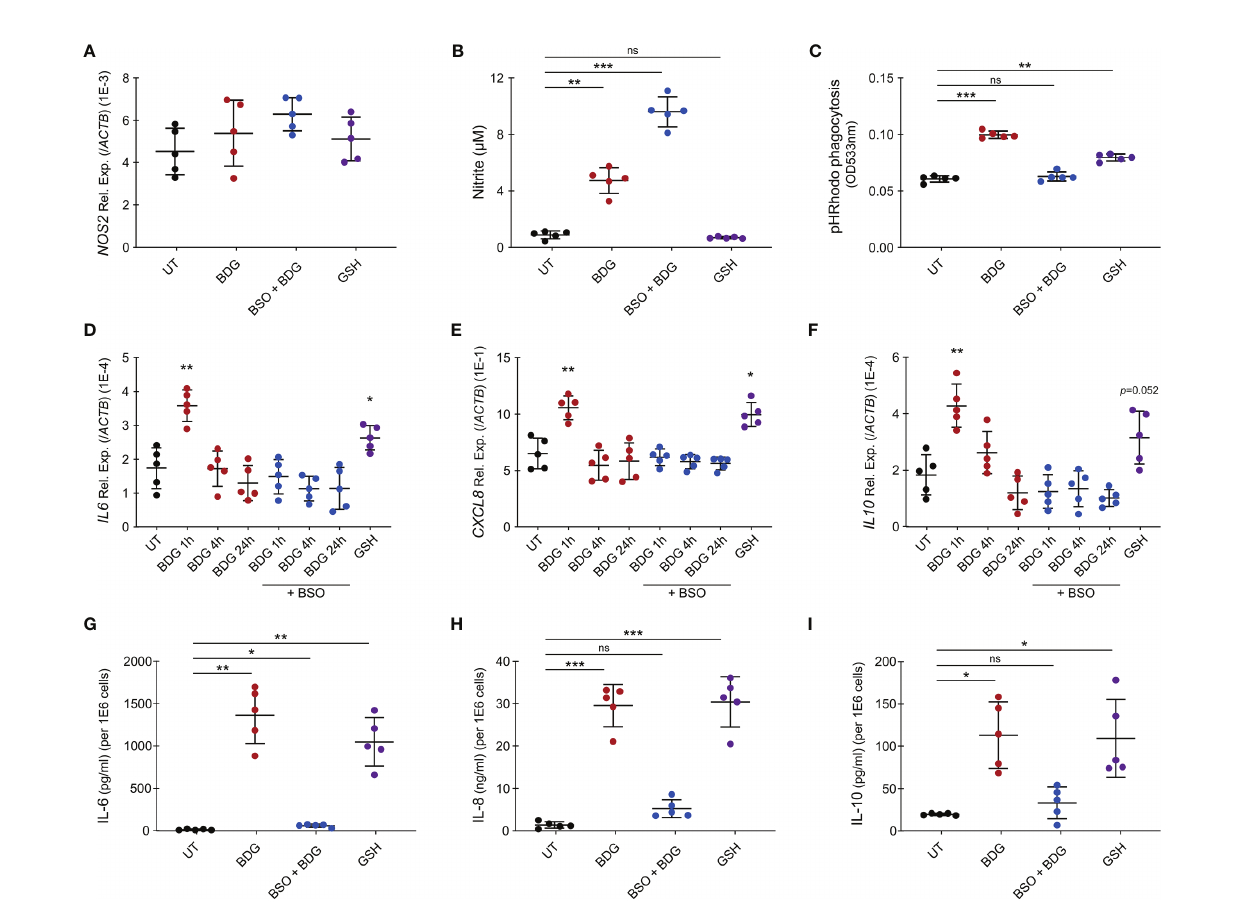
FIGURE 7 | Intracellular glutathione levels modulate monocyte ’ s in fl ammatory response to BDG stimulation. (A – C) Human monocytes were untreated, stimulated with BDG for 24h, pre-treated with BSO for 24h then stimulated with BDG for 24h, or stimulated with reduced glutathione (GSH) for 24h and assessed for (A) NOS2 expression, (B) Nitrite production, and (C) phagocytic capacity. (D – F) Human monocytes were untreated, stimulated with BDG for 1h, 4h, or 24h, pre-treated with BSO for 24h then stimulated with BDG for 1h, 4h, or 24h, or stimulated with GSH for 24h and then evaluated for expression of the (D) IL-6 , (E) CXCL8 , and (F) IL- 10 loci using RT-qPCR. (G – I) Human monocytes were untreated, stimulated with BDG for 24h, pre-treated with BSO for 24h then stimulated with BDG for 24h, or stimulated with reduced glutathione (GSH) for 24h and assessed for production of (G) IL-6, (H) IL-8, (I) IL-10 using ELISA. Data are presented as median ± standard deviation of n = 5 biologically independent experiments. P- values were calculated using paired one-way ANOVA with multiple comparisons. ns, not signi fi cant; * P < 0.05; **P < 0.01; *** P <